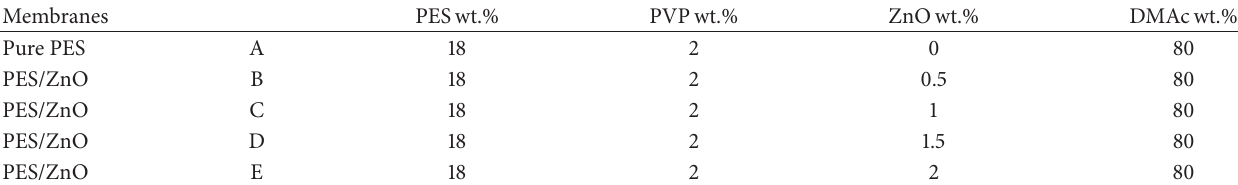
Table 1: Composition of the casting solution used to prepare ZnO/PES membrane composites. Membranes